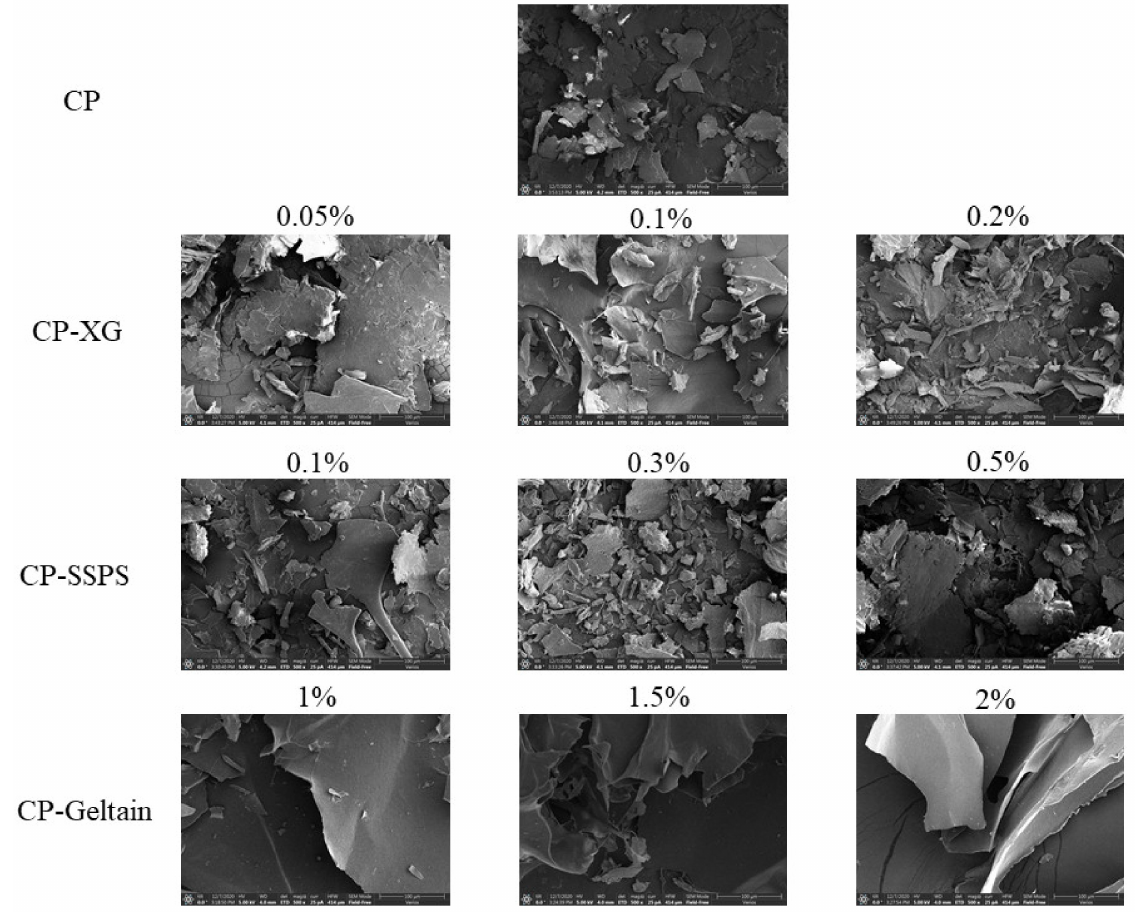
Figure 5. SEM images of CP-Hydrocolloid systems. (CP-Coconut protein, XG-Xanthan gum, SSPS- Soluble soybean